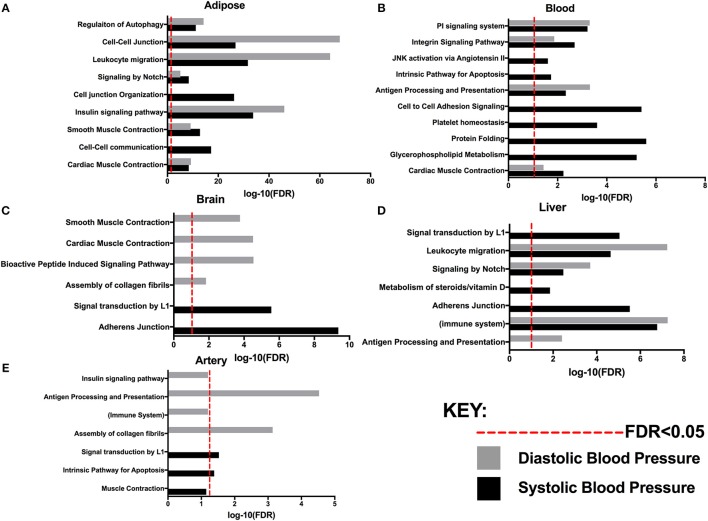
Pathways associated with systolic and/or diastolic blood pressure with FDR determined by MSEA analysis from various tissues: (A) Adipose. (B) Blood. (C) Brain. (D) Liver (E) Artery.